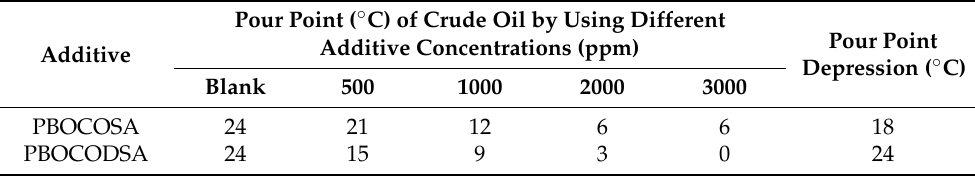
Table 2. Effect of concentration of polymeric additives on the pour point of crude oil. Pour Point (°C) of Crude Oil by Using Different Additive Concentrations (ppm) Additive